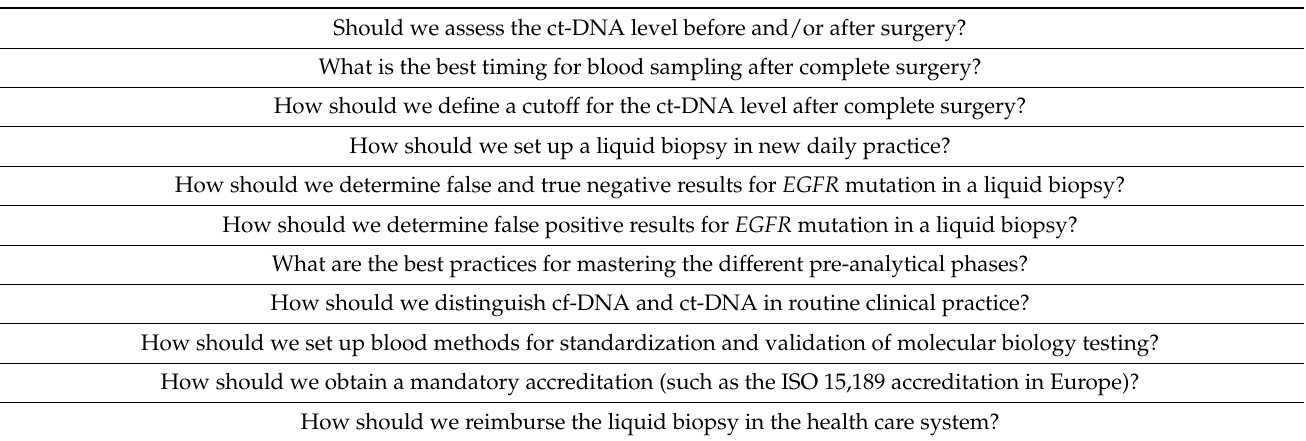
Table 2. Main challenges facing liquid biopsies for early stage NSCLC